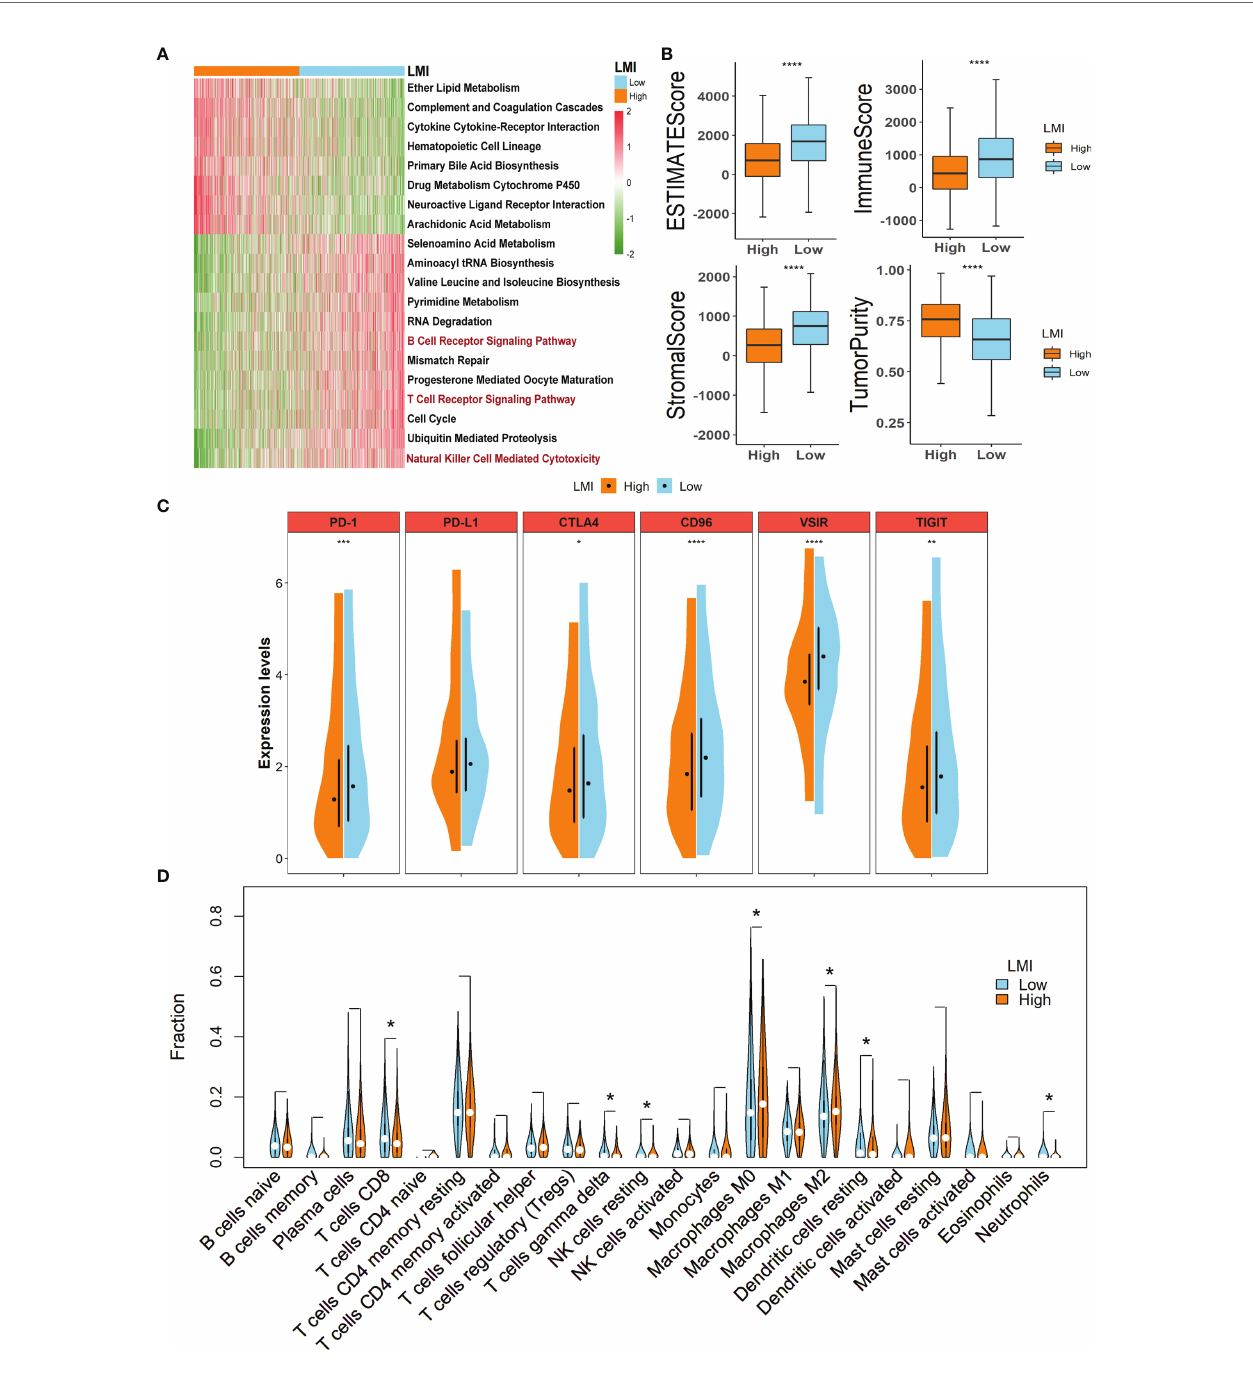
FIGURE 6 | Potential implications for immunotherapy and TME landscape estimation between the high- and low-LMI groups. (A) Results of GSVA in TCGA-BRCA cohort to delineate the enriched pathways. (B) Differences of ESTIMATE score, immune score, stromal score, and tumor purity. (C) Expression levels of immune checkpoints. (D) Violin plots to display the proportions of 22 immune in fi ltrating cells in total BC patients. *p < 0.05; **p < 0.01; ***p < 0.001; ****p <